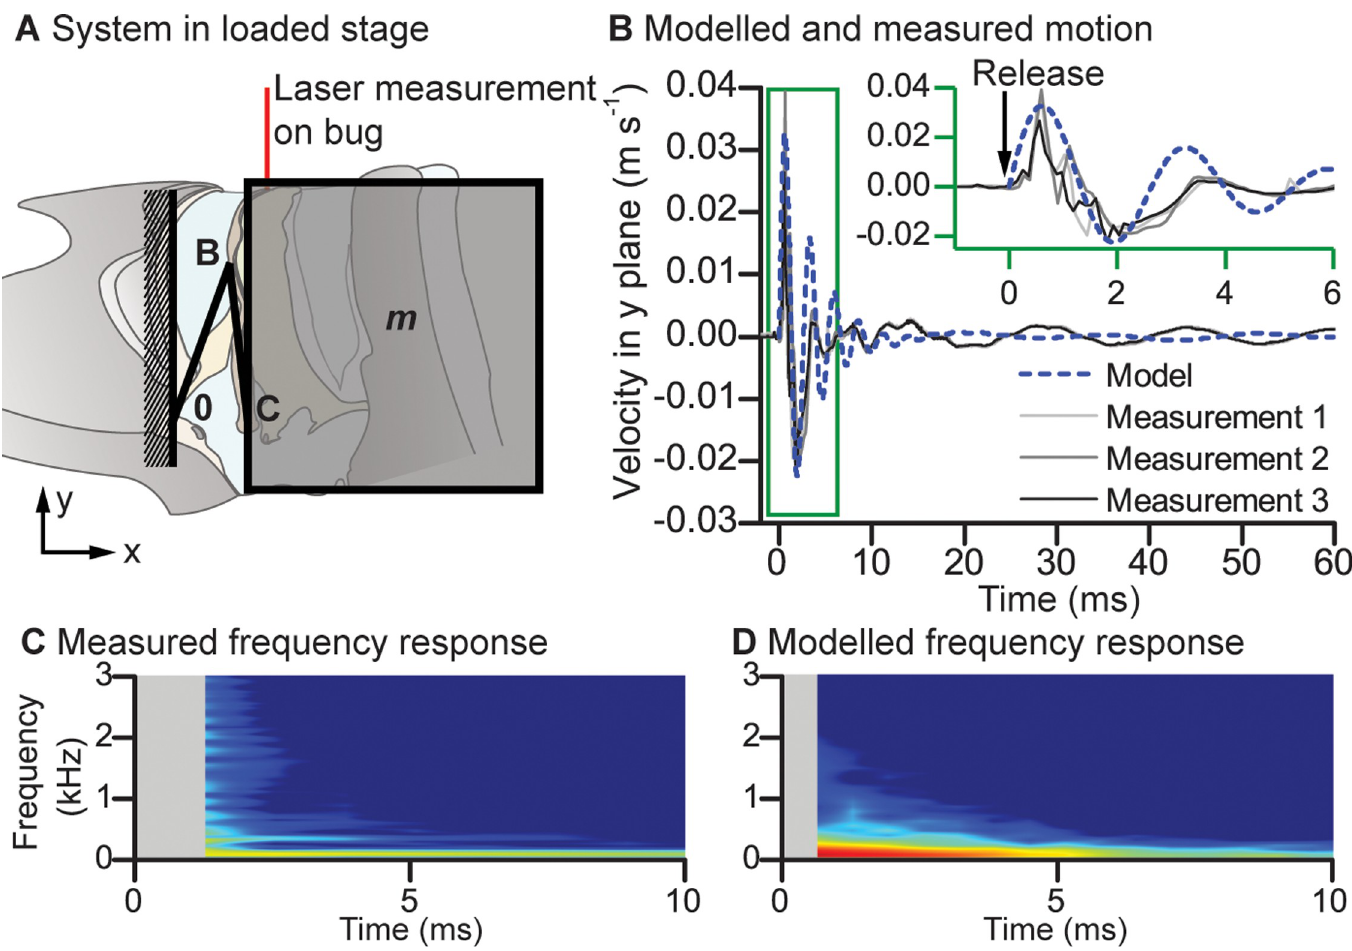
Fig 5. Modelled and measured motion of the snapping organ during unloading. (A) Schematic of the mathematical model and location of the laser vibrometry measurement in relation to the snapping organ. The model comprised two stiff beams in series representing the rg and anterior arm of the lb and could rotate at points 0 (junction of thorax and rg), B (junction of rg and lb), and C (base of lb). The thorax was fixed, but point C was connected to tg2 and the rest of the abdomen’s mass ( m ). Springs and damping elements not shown; see S4B Fig). Modelled (dashed blue line) and measured unloading motions in the dorsoventral direction (black, dark grey, and grey lines; measurements from the midabdomen of the same bug over three different cycles). The inset gives the same data over a shorter timescale, as indicated by the green box. (C and D) Frequency response from measured and modelled outputs, respectively, in which the colour scale gives relative magnitude in arbitrary units on an identical scale from low (blue) to high (red). The underlying data can be found within S1 Data. lb, Y-lobe; rg, ridge; tg2, tergum 2.